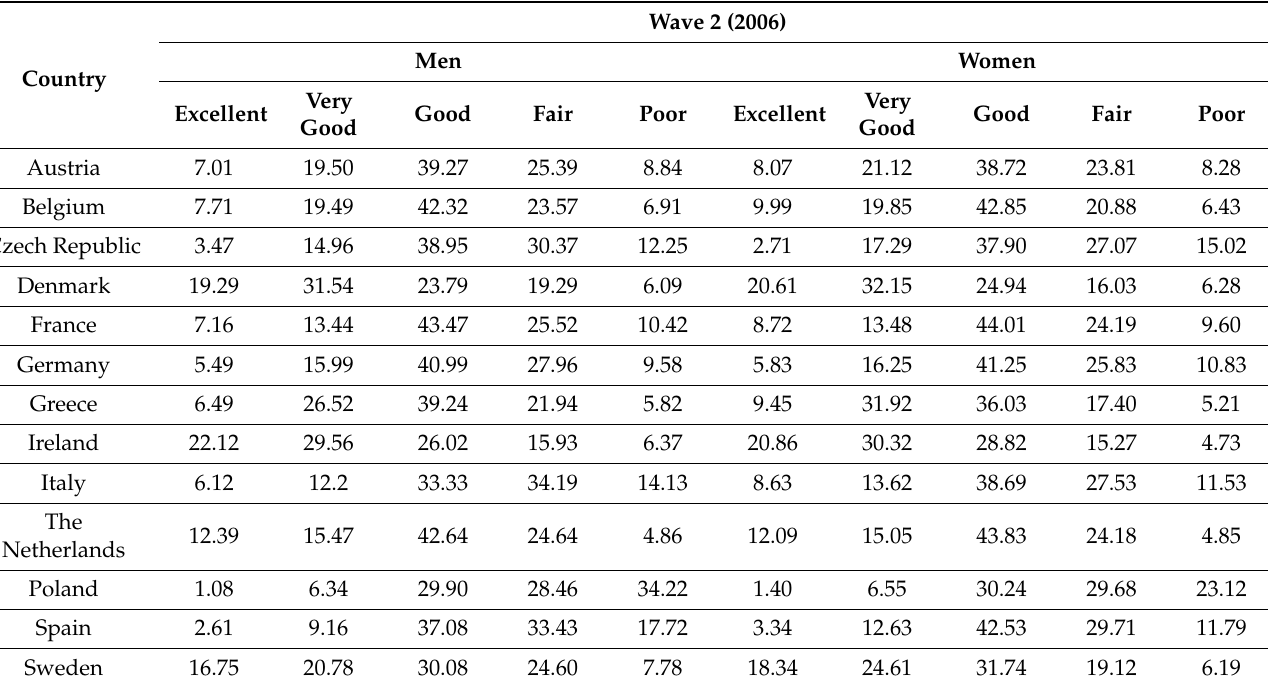
Table 2. Distribution of self-perceived health by gender and country in Wave 2 (2006).